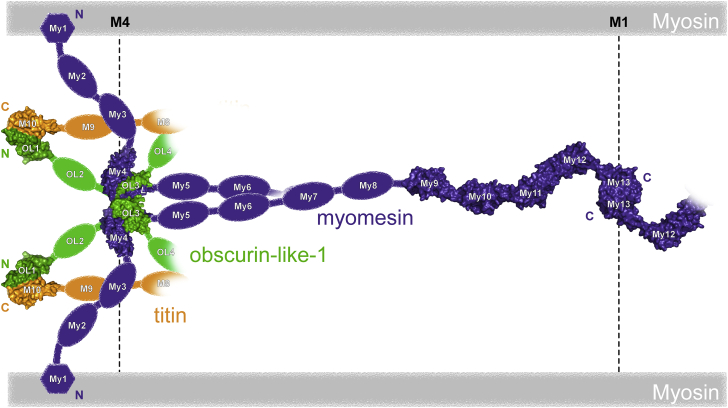
Possible Model for the Organization of the Titin:Obscurin(-like-1):Myomesin Ternary Complex at the M-BandExperimental complexes are shown as surface representation: OL3:My4L dimer (this work), M10:OL1 (Pernigo et al., 2010, Pernigo et al., 2015, Sauer et al., 2010), My9-M13 (Pinotsis et al., 2008, Pinotsis et al., 2012).